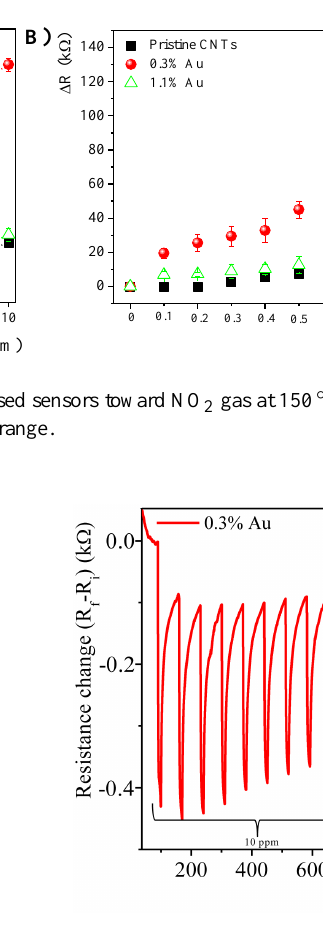
Figure 8. Repeatability test based on time response of functional- ized CNTs with Au loading of 0.3at.% at a working temperature of 150 ◦ C and at 10 and 1ppm of NO 2 , repeating 10 times the expo- sure to each gas concentration.